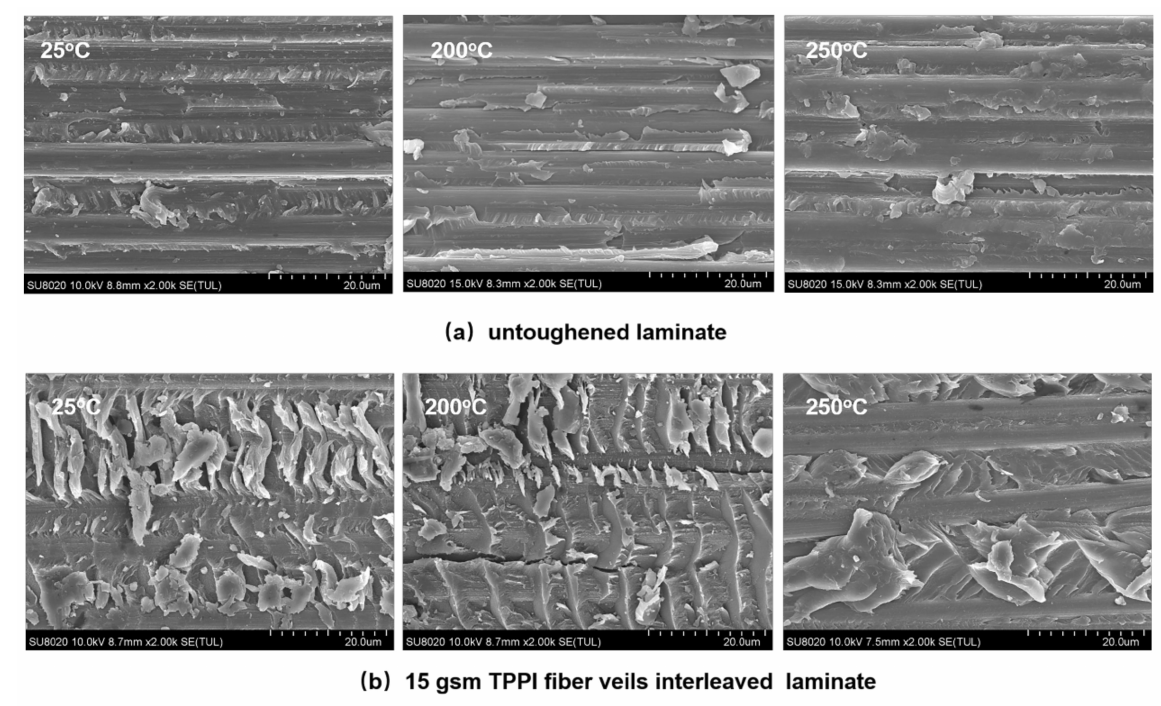
Figure 12. SEM micrographs of mode II fracture surfaces for untoughened and interleaved laminates after the ENF test at different temperature. ( a ) untoughened laminate; ( b ) 15 gsm TPPI fiber veils interleaved